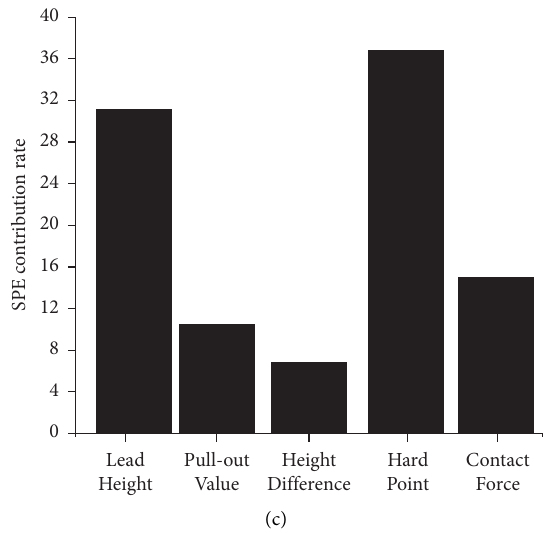
Figure 4: Contribution control chart of group 13 and group 25. (a) T 2 contribution rate chart of group 13; (b) SPE contribution rate chart of group 13; (c) SPE contribution rate chart of group